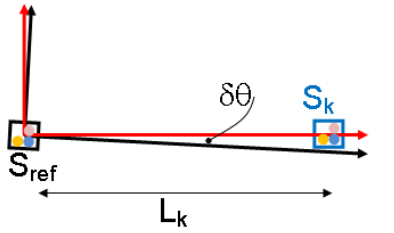
Figure 2. The field components are referred to co-ordinates defined within the reference sensor chip S ref (in black), which might be slightly misaligned with respect to the PCB frame (in red). This can lead to inaccuracy in the position of the other chips ( S k ). In addition, each chip contains three sensors (represented by colored dots), which are (submillimetrically) displaced with respect to each